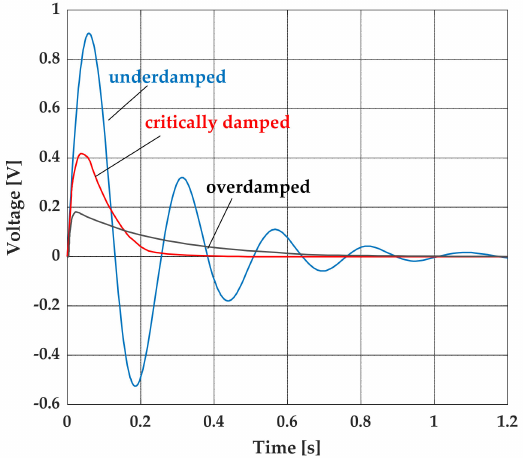
Figure 2. Response of a RLC system to an impulsive